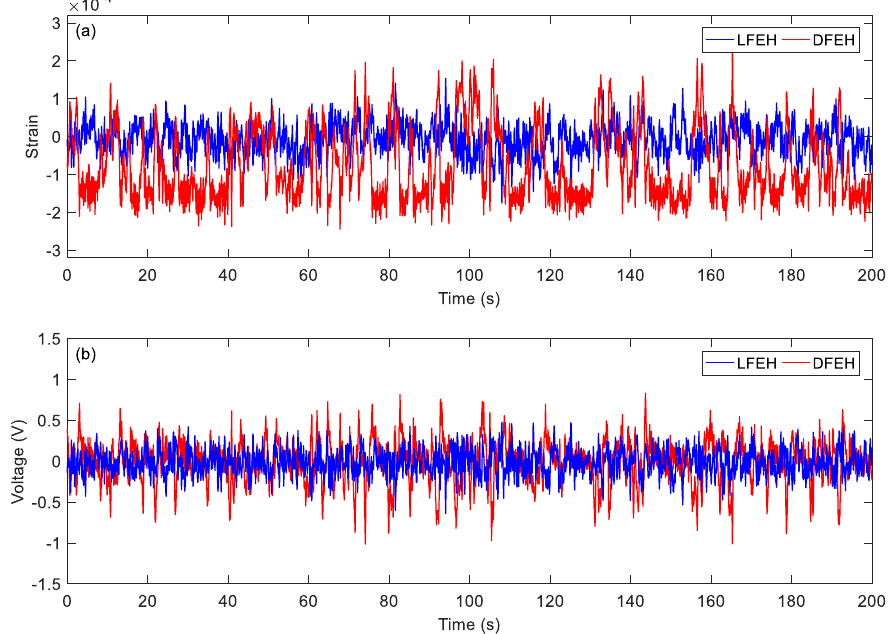
Figure 19. ( a ) Time histories of strain response, ( b ) time histories of voltage response ( v = 7.0 m /